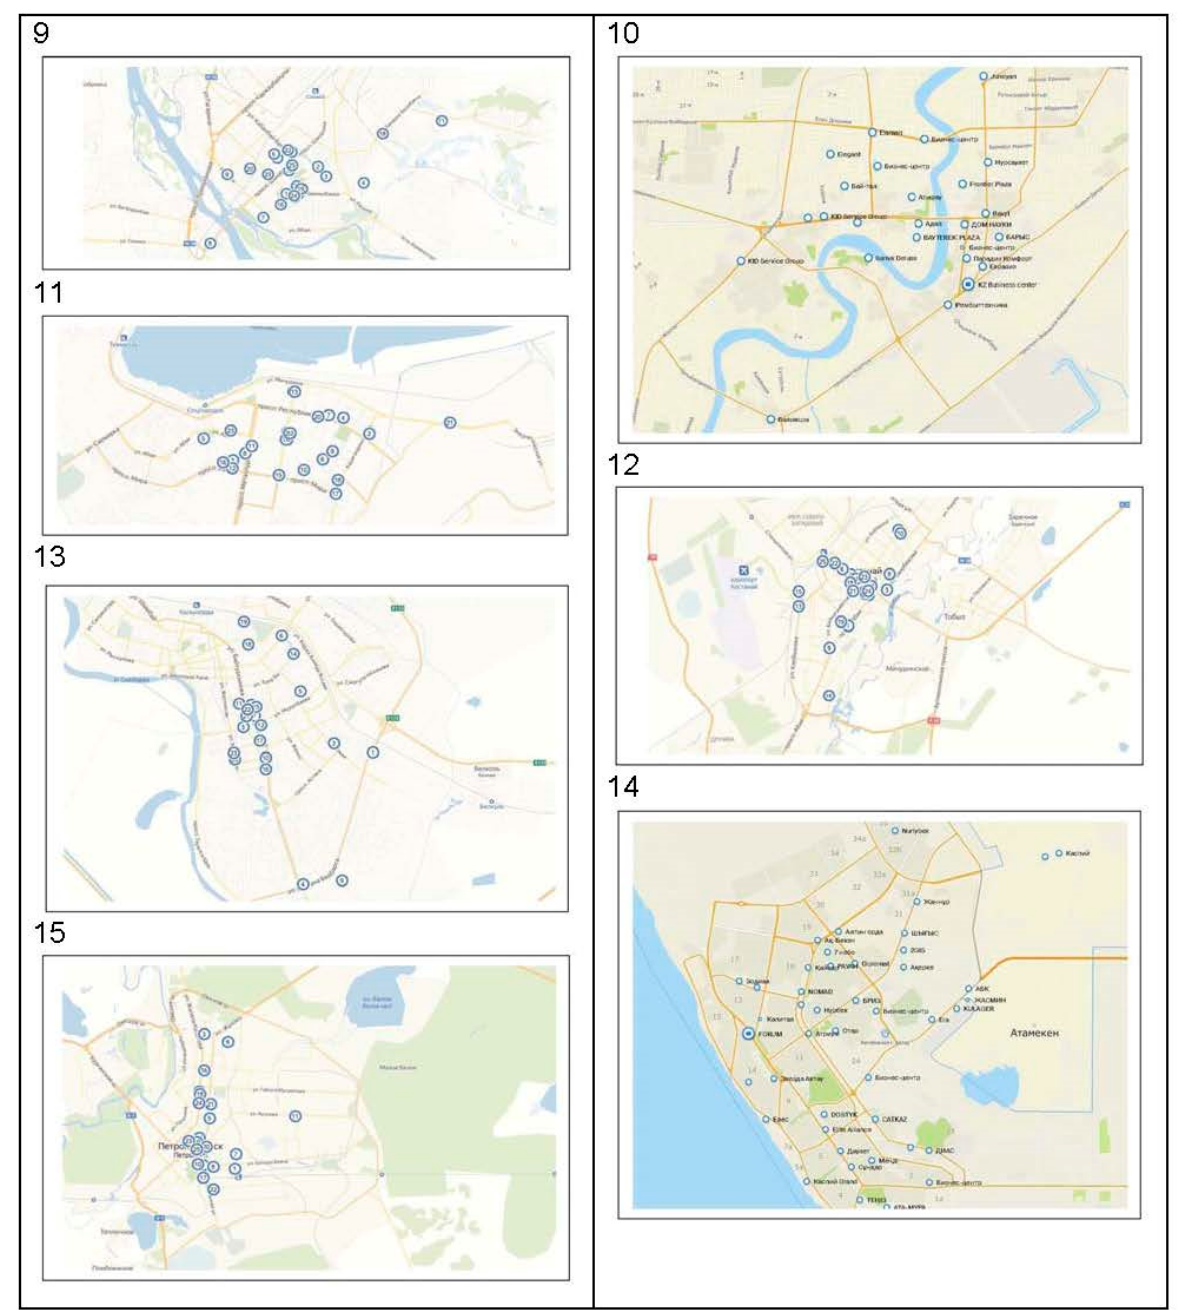
Figure 5. The locations of the main business centers in the city structure: ( 9 ) Semey [83]; ( 10 ) Atyrau [84]; ( 11 ) Temirtau [85]; ( 12 ) Kostanay [86]; ( 13 ) Kyzylorda [87]; ( 14 ) Aktau [88]; and ( 15 ) Petropavlovsk [89].